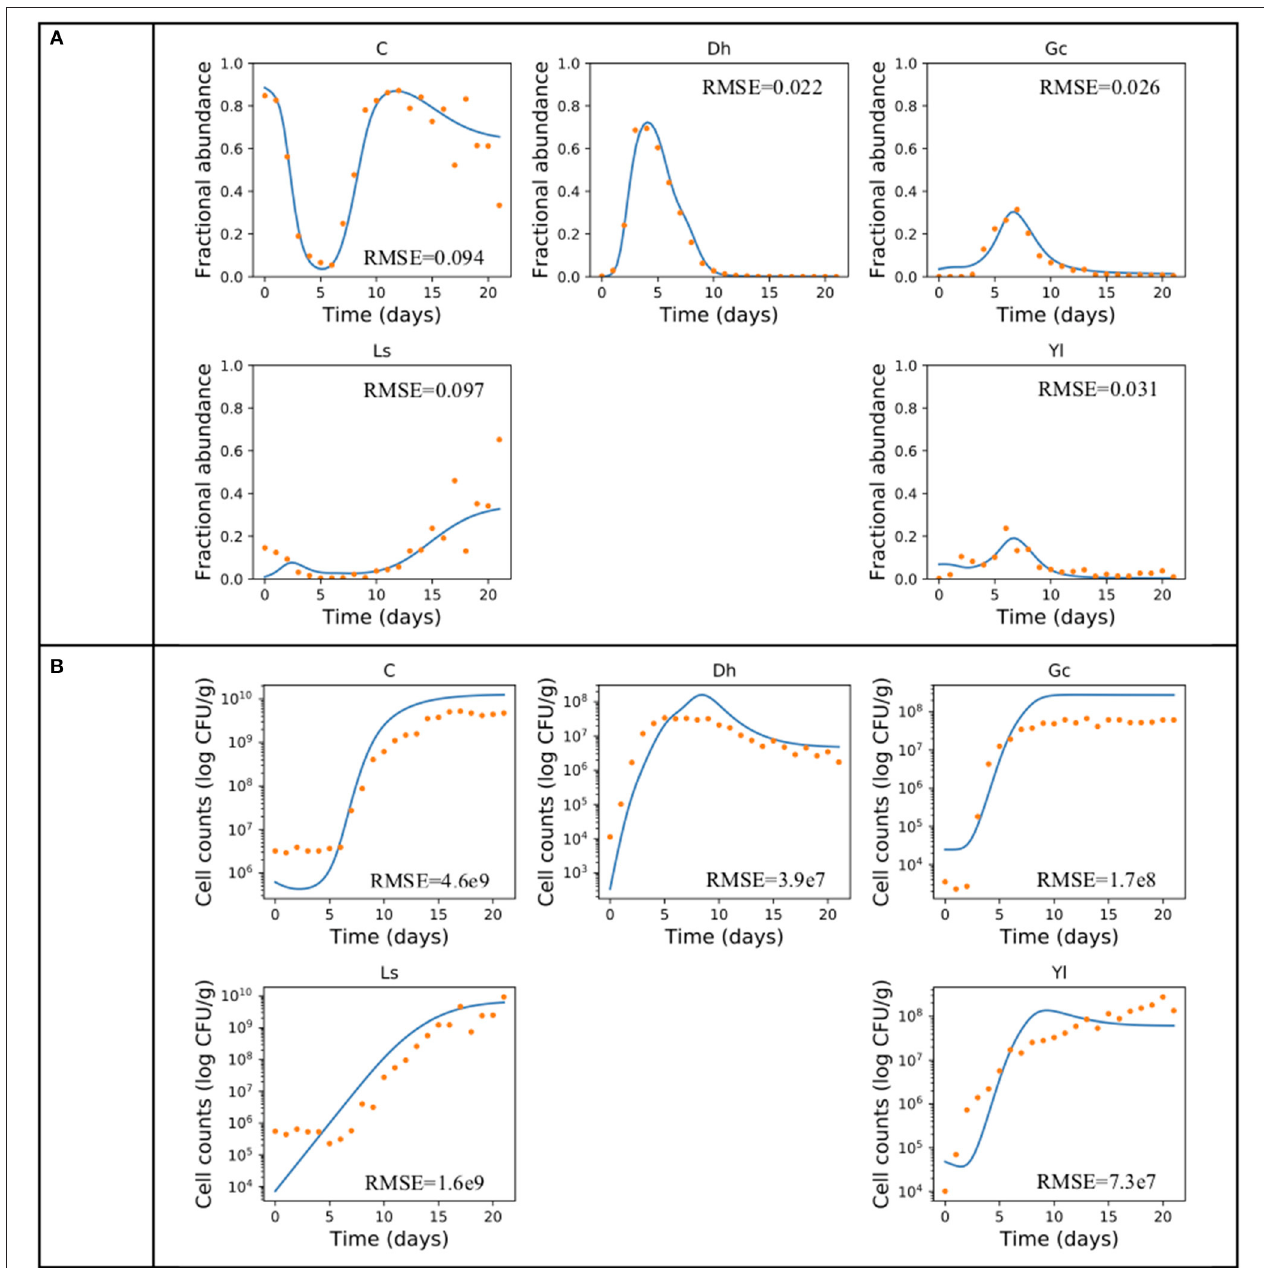
FIGURE 2 | Producing the growth dynamics of the cheese microbial community. An example of using gLV equations and forward stepwise regression describing the growth dynamics of the cheese microbial community in (A) relative abundance and (B) cell count. Experimental data (Mounier et al., 2008) is indicated by dots and the predicted population dynamics are indicated by curves. The fitting performance is measured in root-mean-square error (RMSE). A, Actinobacteria ; Bi, Bacilli ; Ba, Bacteroidia ; C, Clostridia ; G, Gammaproteobacteria